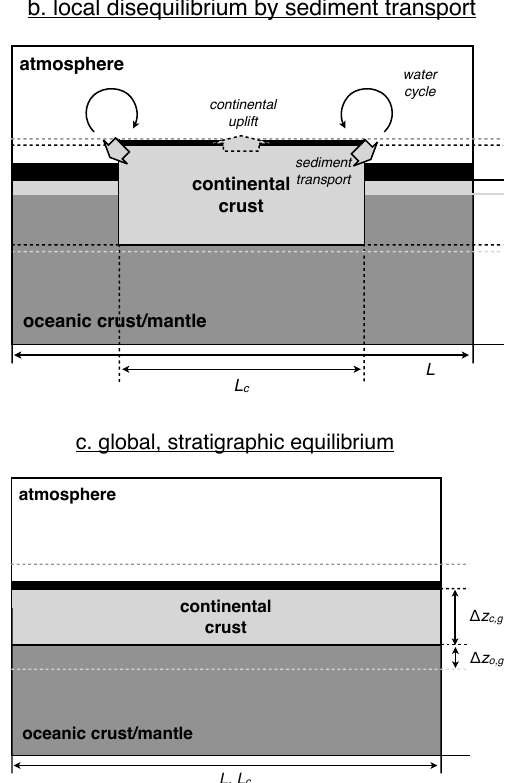
Fig. 1. Highly simplified diagram to illustrate how continental crust evolves from (a) a state of local, isostatic equilibrium through (b) a state with sediment transport to (c) a state of global, stratigraphic equilibrium. Sediment transport provides the means to efficiently transport continental crust along topographic gradients in the hor- izontal and thereby minimizes the potential energy within the sys- tem (see Appendix for details). The ocean is shown in black and plays a critical role here as the driver of the hydrologic cycle (thin arrows), which in turn provides a substantial power source to accel- erate sediment transport. Plate tectonics is excluded for simplicity. The symbols in the figures are used in the Appendix to quantify this direction towards minimizing the potential energy associated with oceanic and continental